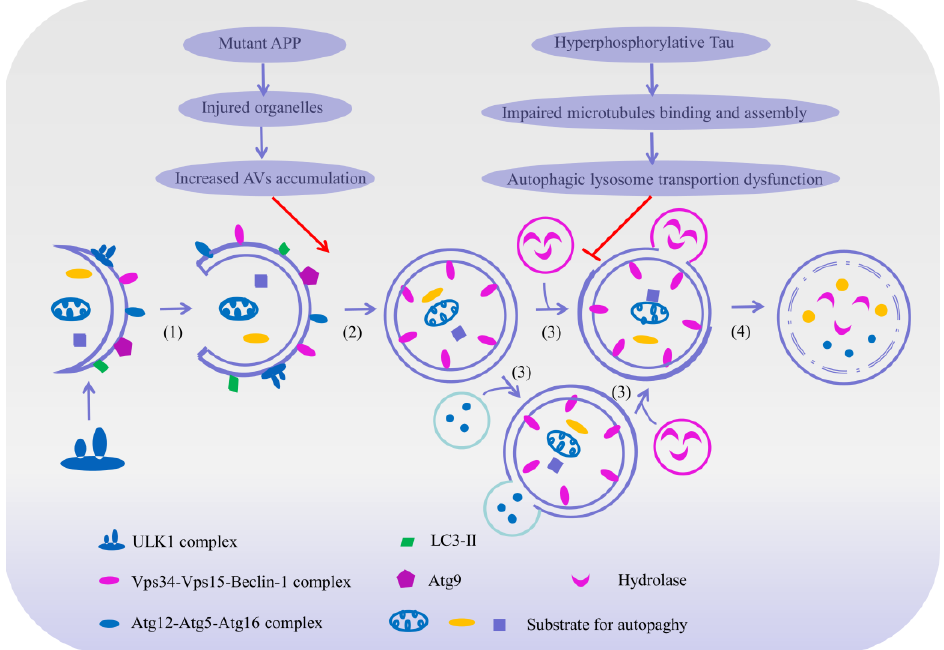
Figure 3. The mechanism of autophagy and its potential role in Alzheimer’s disease. Macroautophagy can be broken down into the following essential steps: (1) Initiation: macroautophagy begins by encasing the abnormal protein or selected organelles with an intracellular bilayer membrane structure to form a primary cup-shaped compartment containing a bilayer membrane called a